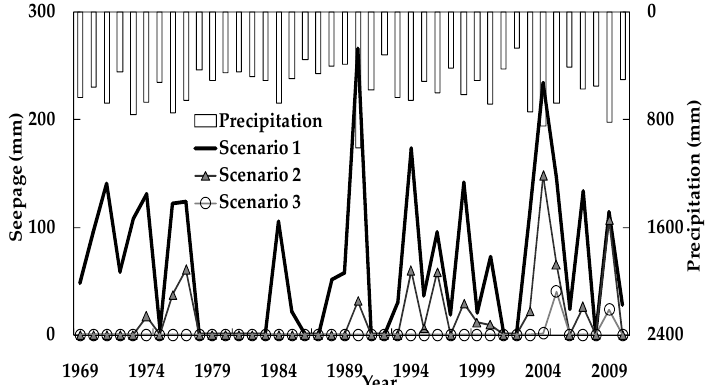
Figure 9. Annual variation in seepage under different scenarios and annual variation in precipitation from 1969 to 2010.